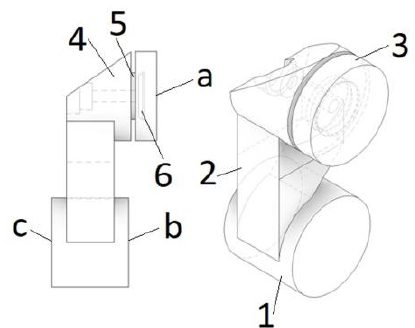
Fig. 7. Model of fluid domain: 1 – intake manifold, 2 – connecting canal, 3 and 4 – the inner volume of EGR valve being the sum of sub volumes, 5 –